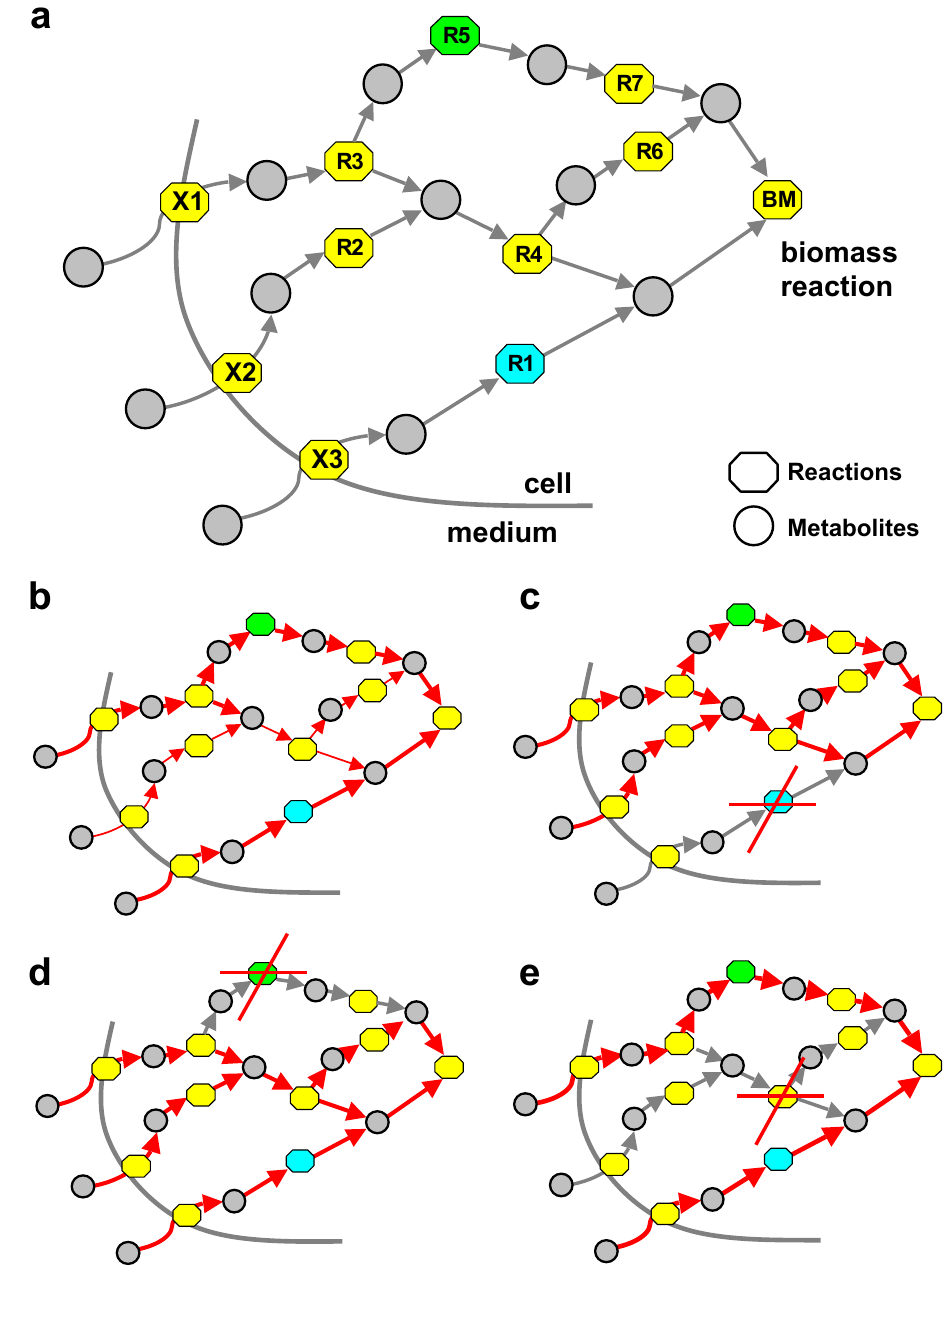
Figure 1. Network context of topological reaction categories. ( a ) Simple scheme of a small fictitious metabolic reaction system with examples of UPUC and SA reactions. ( b ) Wild-type network. ( c ) Knockout of SA reaction R1 . Fluxes are rerouted over R4 leading to an increase in the systems SA. ( d ) Knockout of UPUC reaction R5 . ( e ) Knockout of reaction R4 . R1 (SA) and R5 (UPUC) are now correct essentiality predictors. Edge thickness